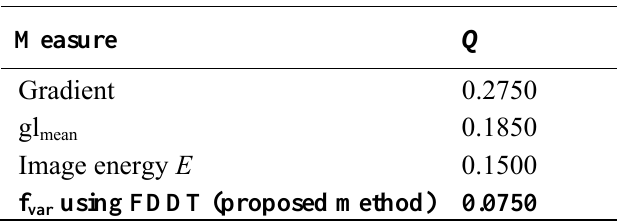
Table 2. Comparative